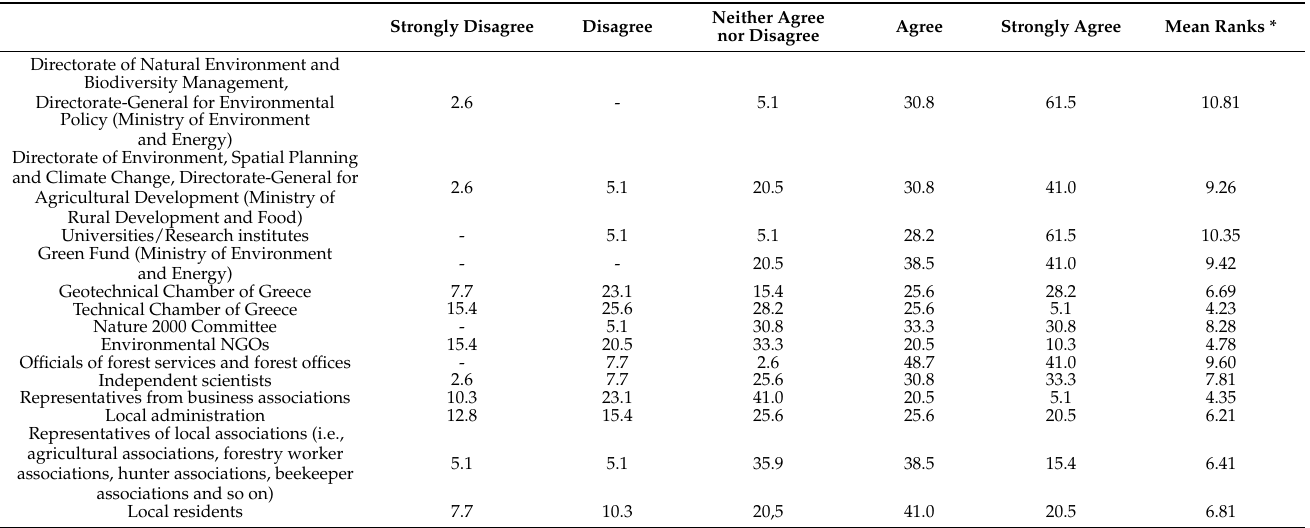
Table 14. Percentage units and differences among responses regarding stakeholders that should participate in the Hub. Strongly Disagree Disagree Neither Agree nor Disagree Agree Strongly Agree